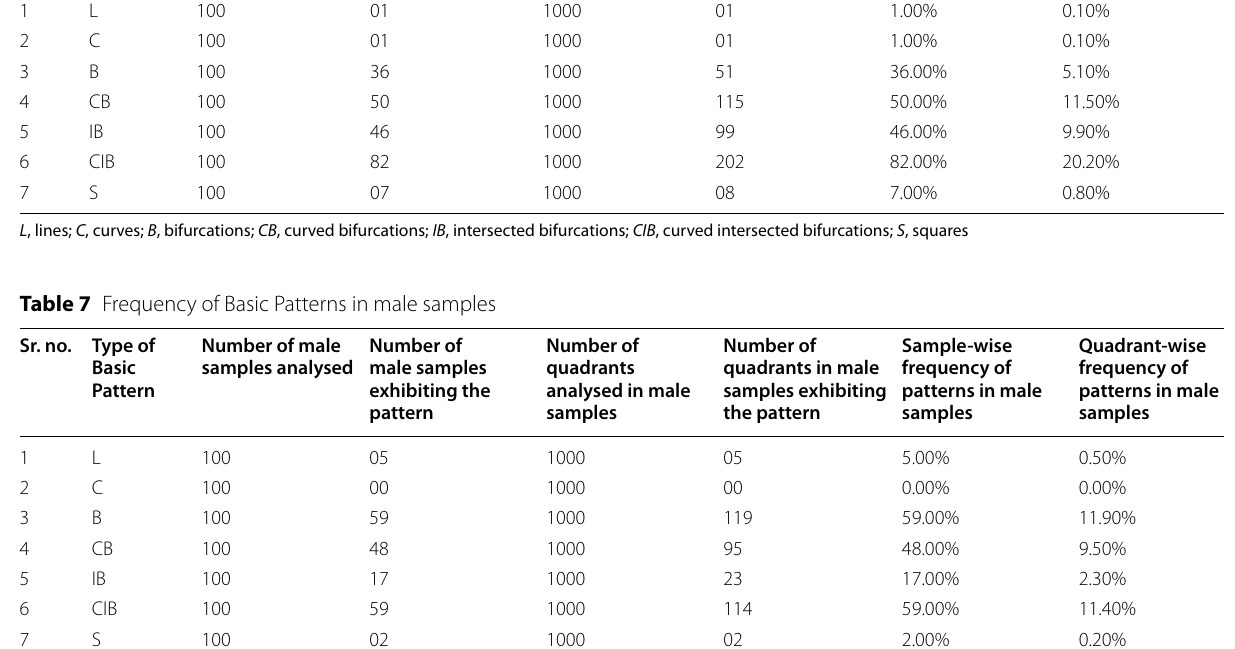
Table 6 Frequency of Basic Patterns in female samples Sr. no. Type of Basic